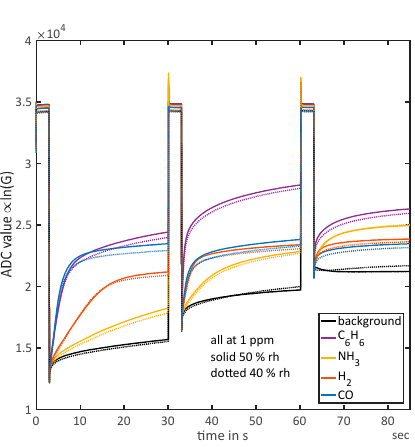
Figure 1. Sensor signal for all gases at 1 ppm and background gas (zero air) at both humidities measured (40% RH and 50% RH), the measured ADC-values are proportional to the logarithmic conductance due to the logarithmic amplifier. Temperatures: 0–3 s 450 ◦ C, 3–30 s 150 ◦ C, 30–33 s 450 ◦ C, 33–60 s 200 ◦ C, 60–63 s 450 ◦ C and 63–90 s 250 ◦ C.